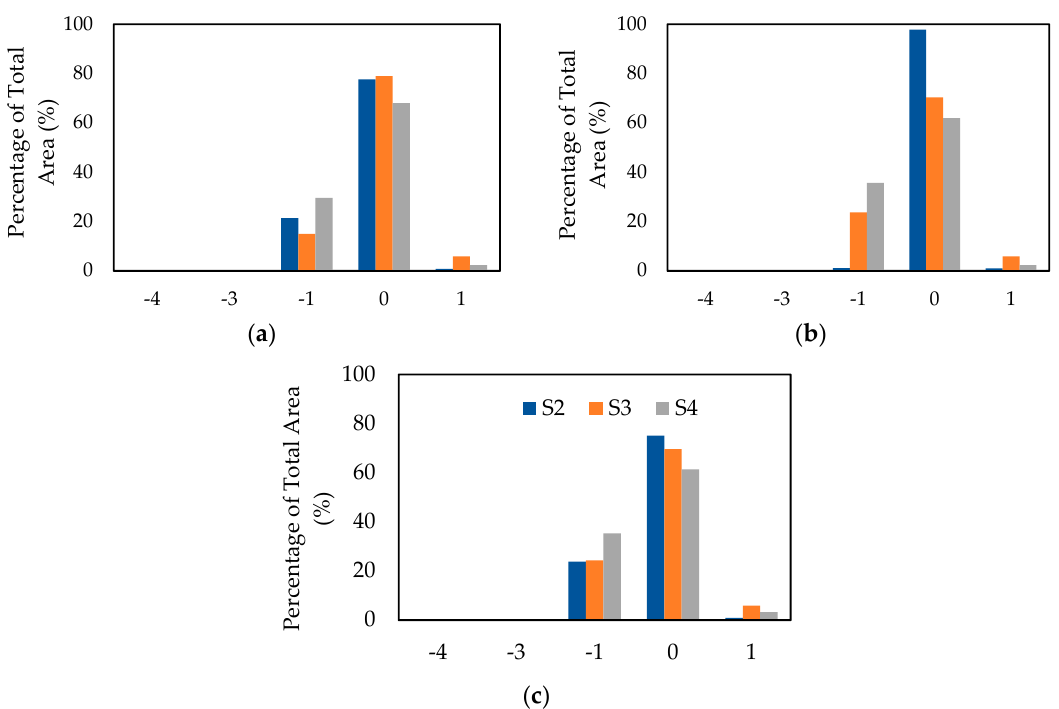
Figure 10. Flood risk change for each vulnerability scenario ( a ) V1; ( b ) V2; and ( c ) V3.